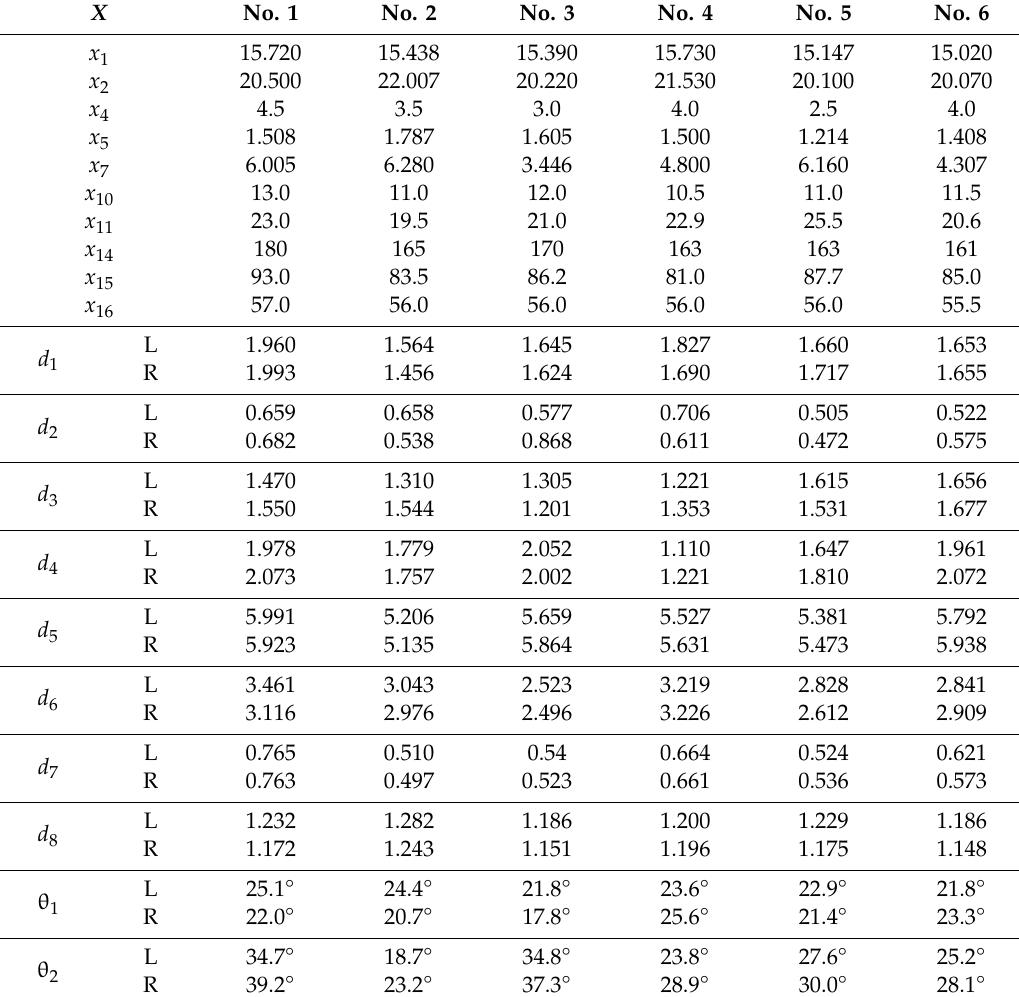
Table 6. Dimensions of the anthropometric parameters for six subjects (Unit: